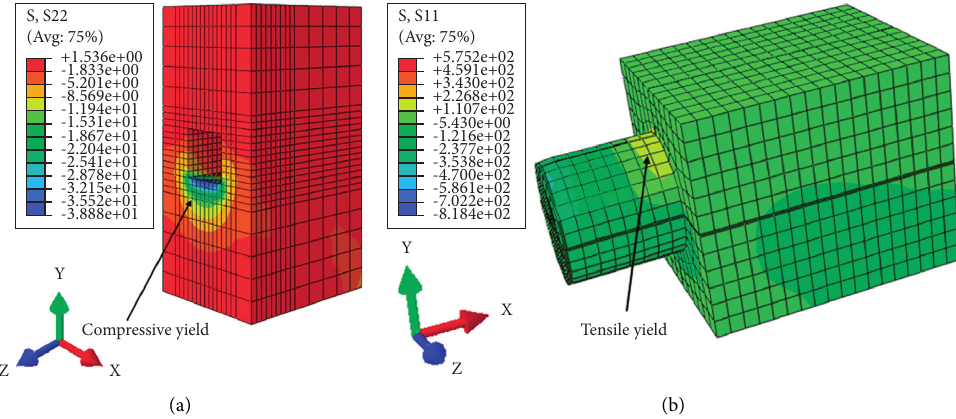
Figure 17: Stress nephogram of concrete and steel shear key in ultimate bearing capacity stage. (a) Stress nephogram of the concrete and (b) stress nephogram of the steel shear key. Table 3: Maximum bearing capacity of steel shear keyed joint under different working conditions. Diameterof thetenon (mm) Sizeof anchorhead(mm) Construction